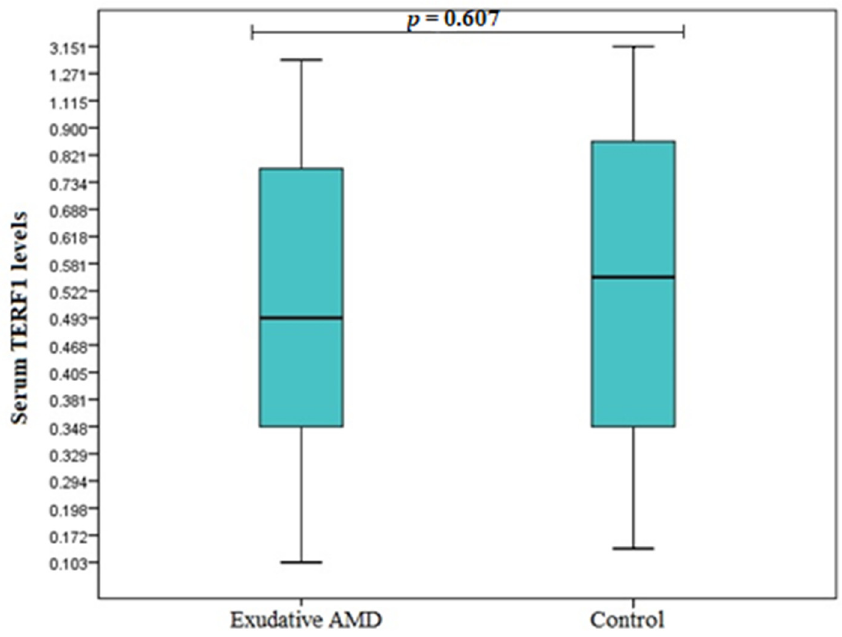
Figure 5. Serum levels of TERF1 in patients with exudative AMD and control group. AMD: age- related macular degeneration; Serum protein values are presented as median and IQR. Mann–Whitney U test was used to assess serum TERF1 levels differences between patients with exudative AMD and control groups; p = 0.607.